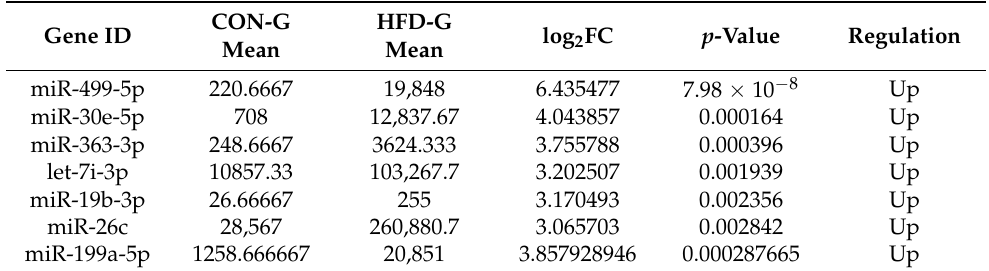
Table 2. Differential expression information of top 10 upregulated and top 10 downregulated DEMs between CON–G and